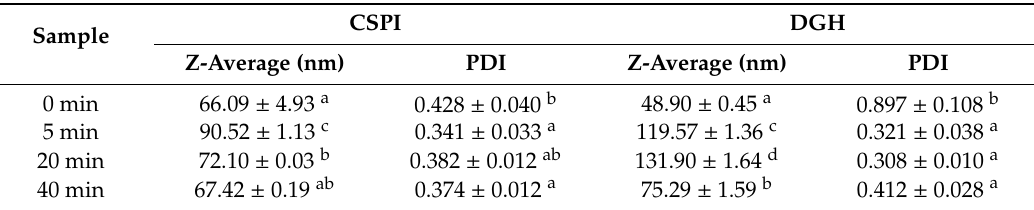
Table 2. E ff ect of high-intensity ultrasound treatment (20 kHz at 400 W for 0, 5, 20, 40 min) on the average particle size (Z-average) and polydispersity index of CSPI and